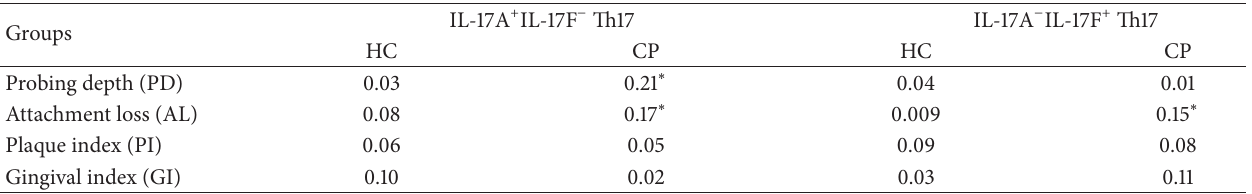
Table 2: Correlation coefficients ( 𝑅 squared) between two distinct Th17 cells (IL-17A + IL-17F − and IL-17A − IL-17F + Th17) expression level and clinical parameters of CP and HC